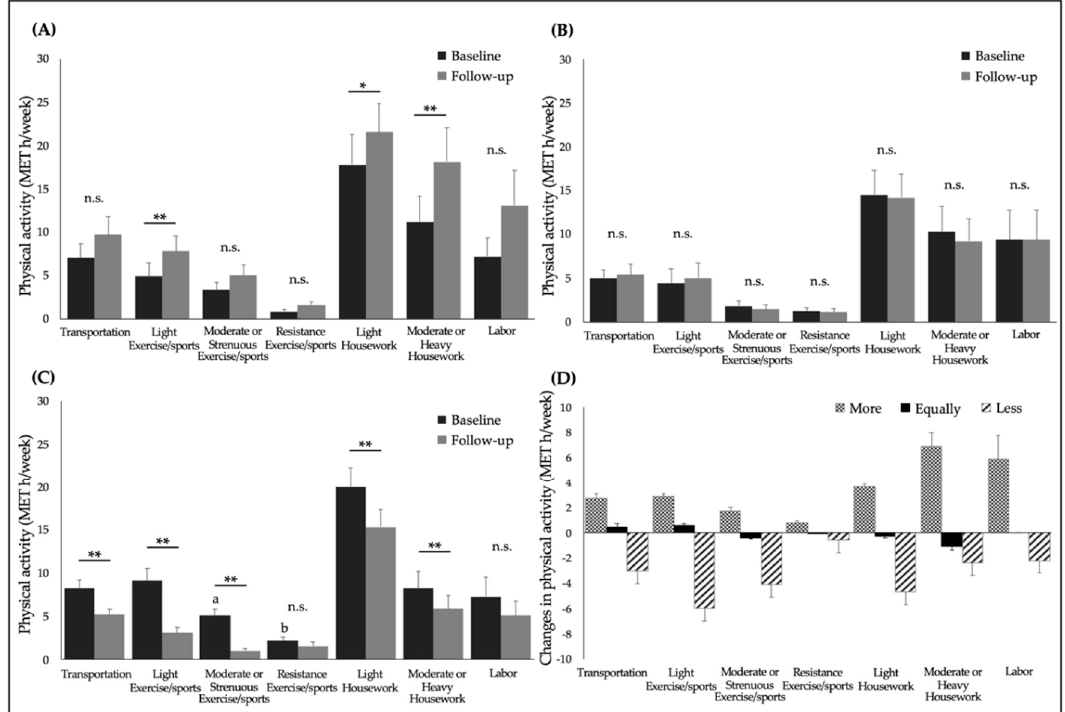
Figure 1. The changes in physical activity at baseline and follow-up after coronavirus disease (COVID-19) restrictions. ( A ) More active group ( n = 38); ( B ) equally active group ( n = 48); ( C ) less active group ( n = 78); ( D ) changes in physical activity. Each category of physical activity was calculated in MET h / week. Data are expressed as the mean ± SEM. **: p < 0.01; *: p < 0.05; a: significant di ff erences between the less active group and equally active group at baseline; b: significant di ff erences between the less active group and more active group at baseline. n.s.: not significant. Interaction e ff ect: total, F = 57.7, p < 0.01; transportation, F = 8.5, p < 0.01; light exercise / sports, F = 17.3, p < 0.01; moderate or strenuous exercise / sports, F = 14.8, p < 0.01; light housework, F = 3.3, p < 0.05; moderate or heavy housework, F = 11.2, p < 0.01; labor, F = 6.6, p < 0.01.